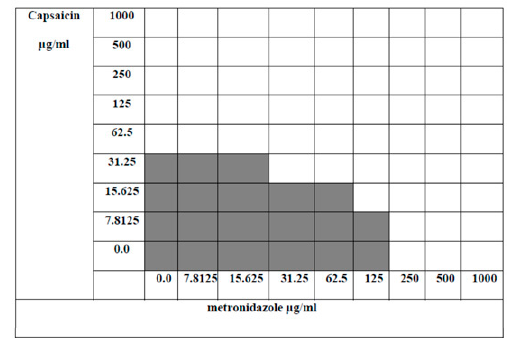
Fig. 4. Checkerboard method showing the prepared diluted concentrations of capsaicin and metronidazole (bolded squares refers to a positive bacterial growth)